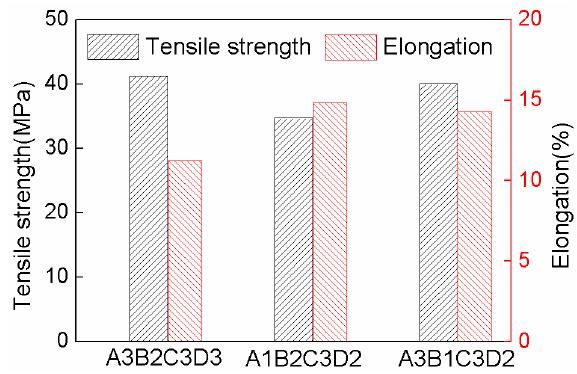
Figure 4. Comparison on tensile properties for different printing parameters.